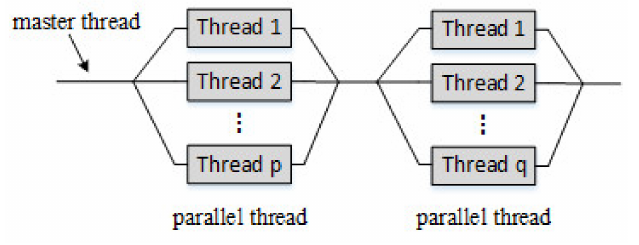
Figure 9. OpenMP’s fork-merge model.